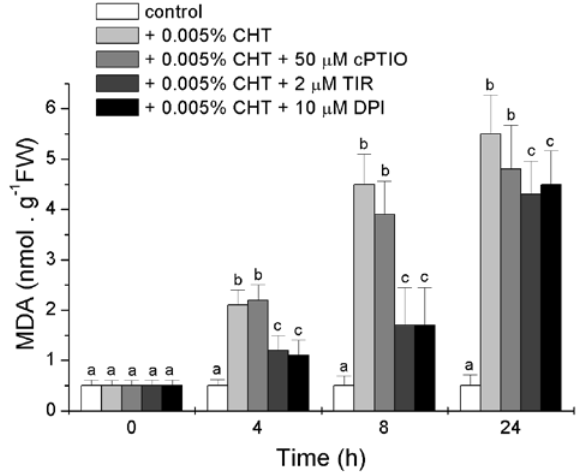
Figure 5. Effect of CHT, cPTIO, Tiron and DPI on the level of lipid peroxidation. Mean values ± SD ( n ≥ 9) are presented. Different letters indicate significant differences among treatments at each experimental time (Tukey HSD test, p ≤ 0.05). MDA: